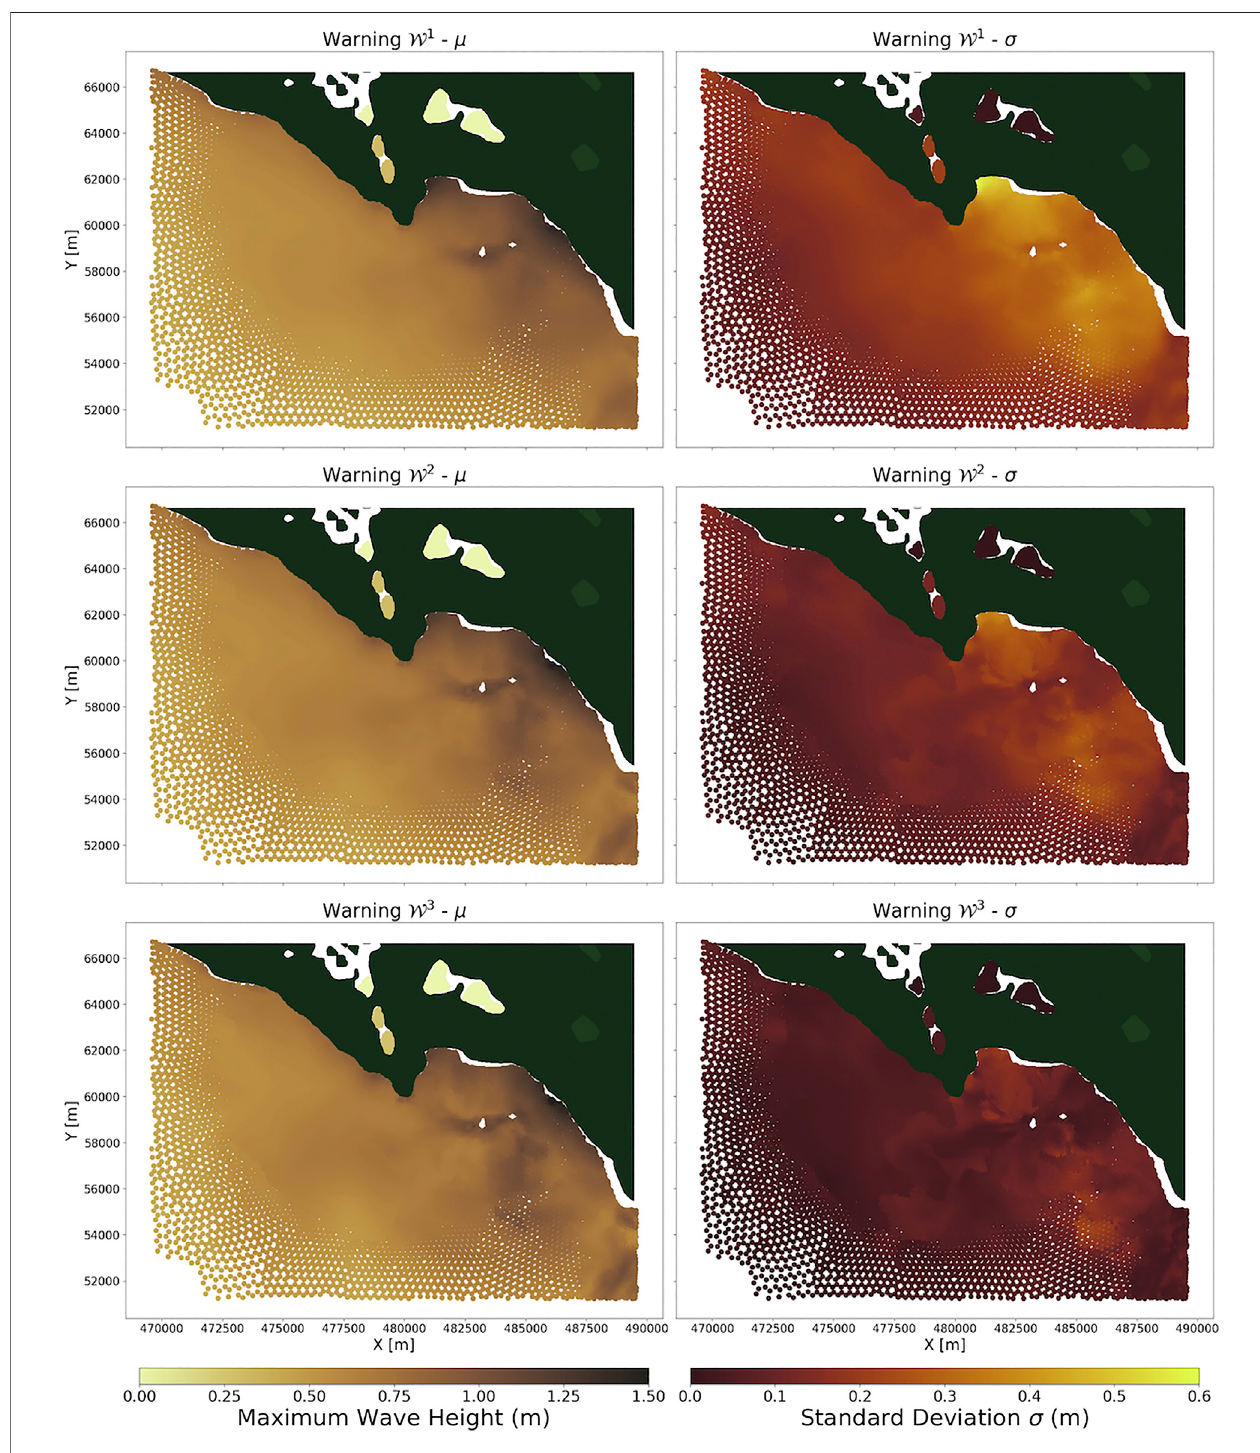
FIGURE 10| Local map ofuncertainties generated from emulator predictions of η max at 19,749 gauges (barycentres ofmesh triangles) near Karachi, for fi rst (top) , second (middle) andthird (bottom) stagesofwarning.Eachwarningstagedepictsthemeanofthepredicted η max (left) andassociatedstandarddeviation (right) using n P (cid:2) 1 k samples for prediction ( Figure 6 , Bottom row).